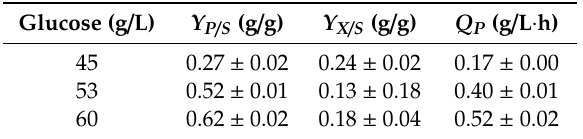
Table 7. E ff ect of the substrate concentration on the fermentation parameters obtained during the production of itaconic acid by A. terreus from cellulose pulp hydrolysate. Glucose (g / L) Y P / S (g / g) Y X / S (g / g) Q P (g / L ·